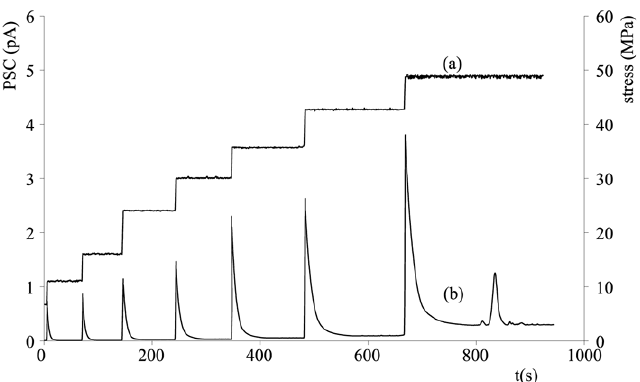
Figure 2. Recording (a): The sequence of the seven stress steps. Recording (b): The corresponding temporal variations in the PSC emissions recorded.